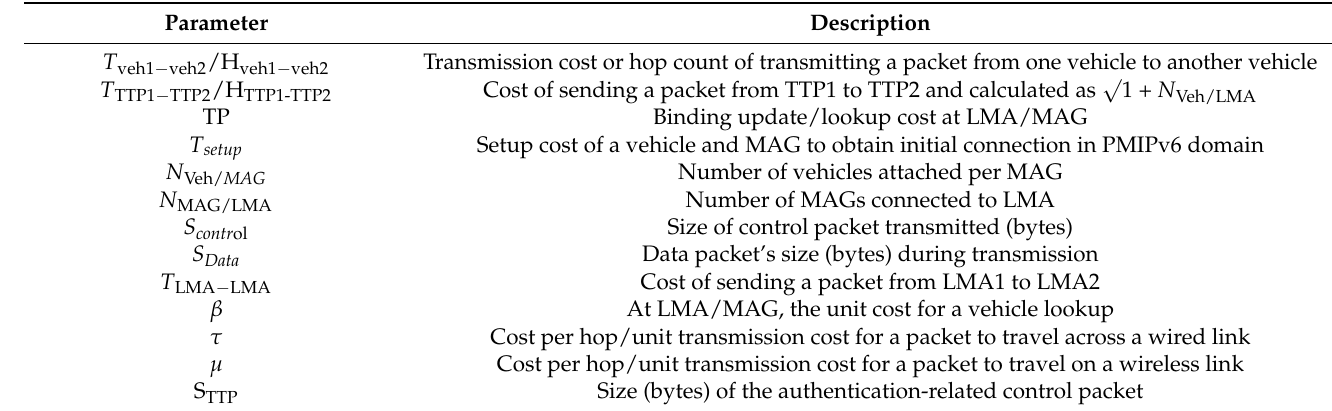
Table 1. List of parameters used to analyze the handover cost of a